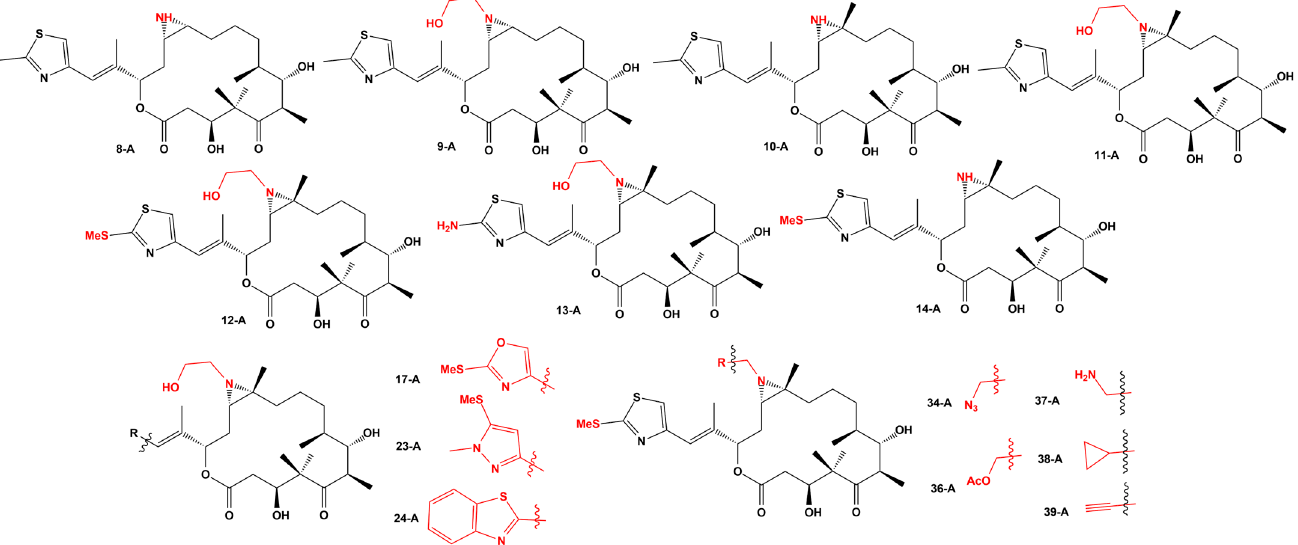
Figure 6. Structure of selected 12, 13-Aziridinyl epothilones with cytotoxic activity. Table 5. Cytotoxicity values for 12, 13-Aziridinyl epothilones in various cancer cell lines (IC 50 in These findings open the possibility for more potent anticancer epothilone derivatives nM). which must bestudied further to assess the pharmacological properties in clinical